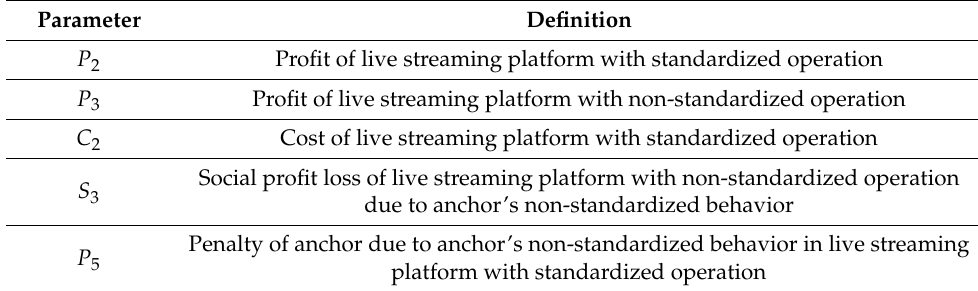
Figure 14. Game tree of “live streaming platform–anchor–consumer”. Table 11. Definition of parameters involved in the game process between government and online live streaming